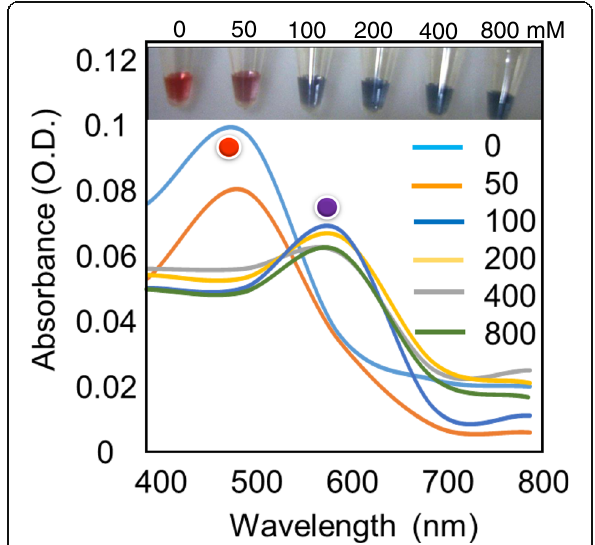
Fig. 2 Optimization of divalent ions. From 0 to 800 mM of NaCl were mixed with constant GNP (1 O.D.). After 15 min, scanned at the wavelength from 400 to 800 nm. Photographs were taken by the digital camera as in figure inset. The spectrum and color changes are indicated by the aggregation of GNP with 100 mM NaCl. Peaks were indicated with the respective colored spheres